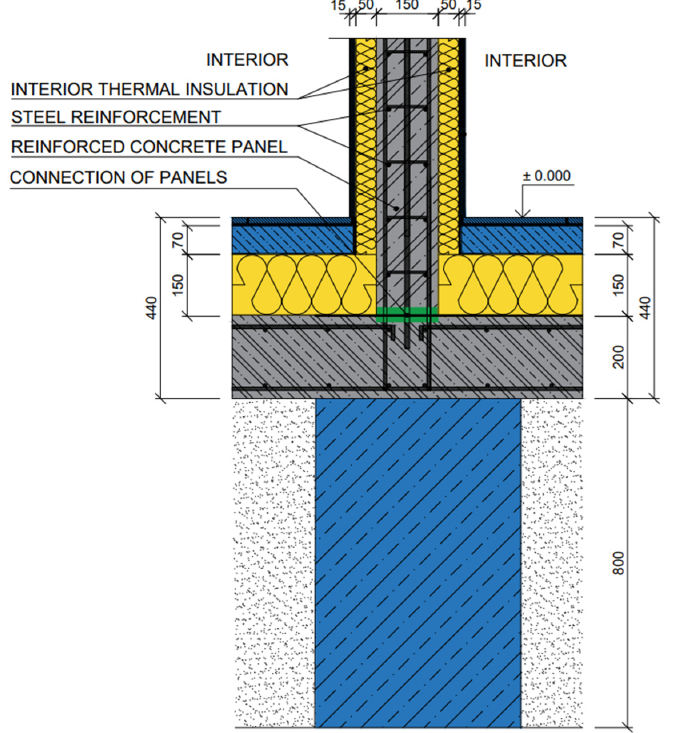
Figure 14. “Detail D”, the connection of the inner load-bearing panel to the base plate.